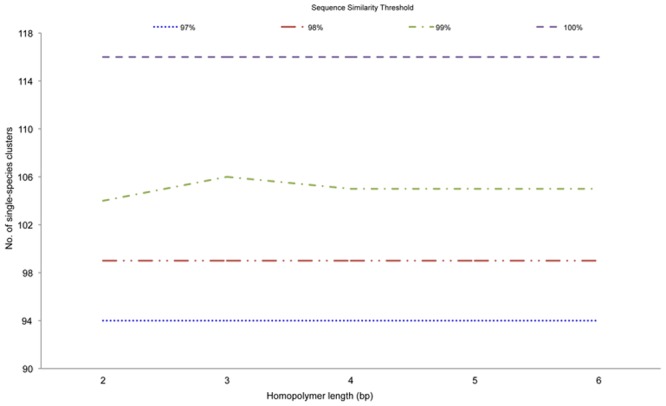
Cluster analysis conducted on modified reference libraries (characterized by 5-mer, 4-mer, 3-mer and 2-mer homopolymers, respectively) using different similarity thresholds (97–100%, at 1% intervals).